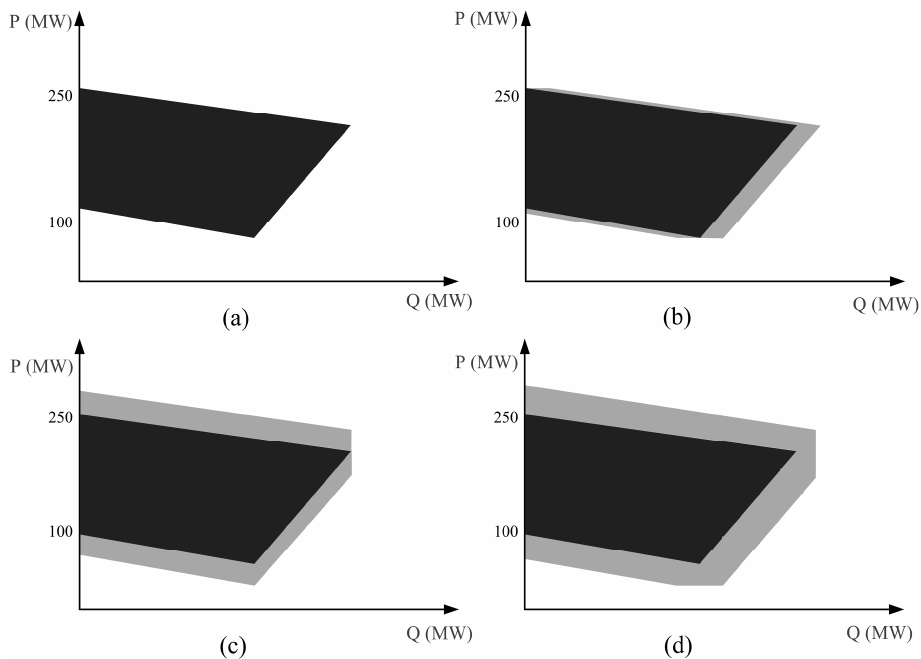
Figure 4. The equivalent heat-power feasible operation region of a CHP unit ( a ) without TES or EES; ( b ) when coupled with TES; ( c ) when coupled with EES; and ( d ) when coupled with both TES and EES.